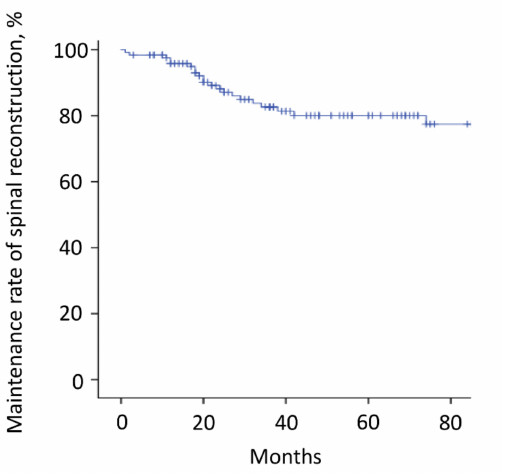
Figure 5. Instrumentation failure. The instrumentation failure rate requiring revision surgery was 22% (27 patients). The 3-year and 5-year maintenance rates of spinal reconstruction without instrumentation failure were 83% and 80%, respectively. Nineteen patients (70%) had the revision surgery within 3 years after metastasectomy. The tick marks indicate the last date of